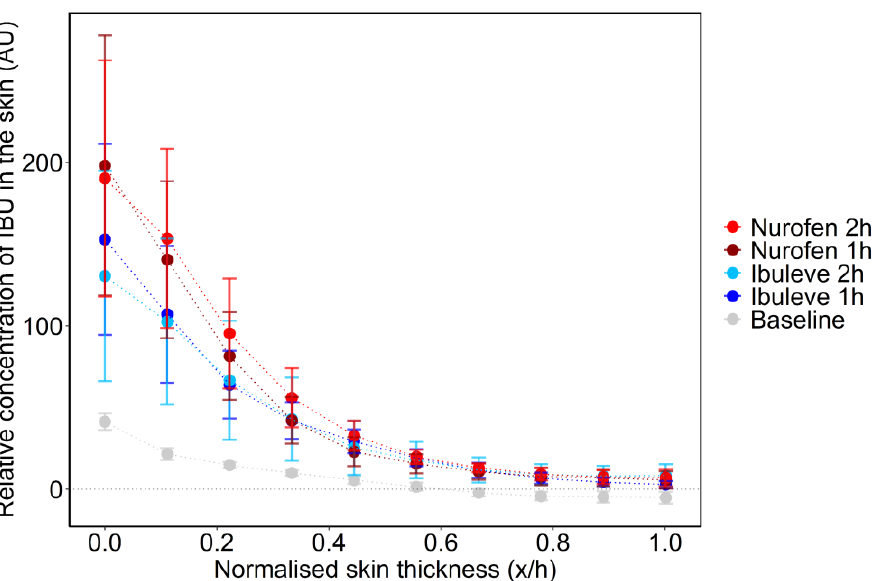
Figure 4. Depth profiles of IBU (AU) across the human volar forearm skin as a function of distance to the skin surface following a 1 h and 2 h application of formulations in vivo (mean ± SEM of 4 subjects; n = 8 replicates per subject).